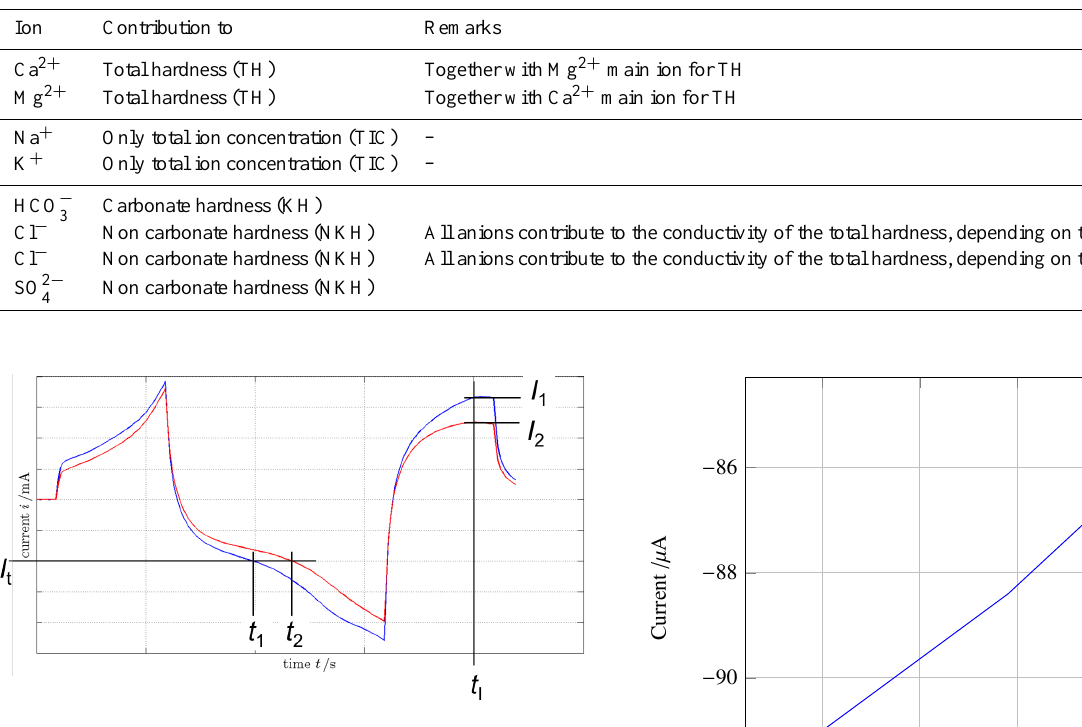
Figure 8. Current response as a function of carbonate hardness.